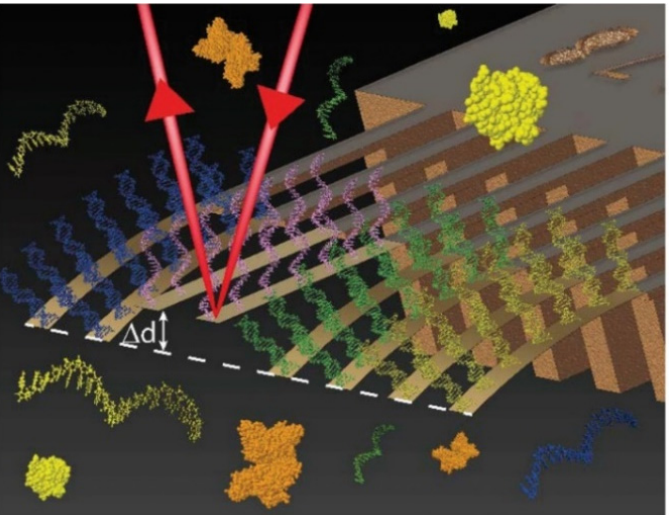
Figure 9. Illustration of target binding on the cantilever array surface. Perspective is from inside the fluidic chamber. The laser from the optical beam read out detection method is shown reflecting away from a cantilever surface, out of the chamber, and towards the detector. Differential deflection ( ∆ d) arises between the in situ reference probes and target sensitive probes [70], reprinted with permission from Royal Society of Chemistry. Table 3. Summary of introduced optical and electromechanical biosensors for liver cancer-related ncRNA detection. Target